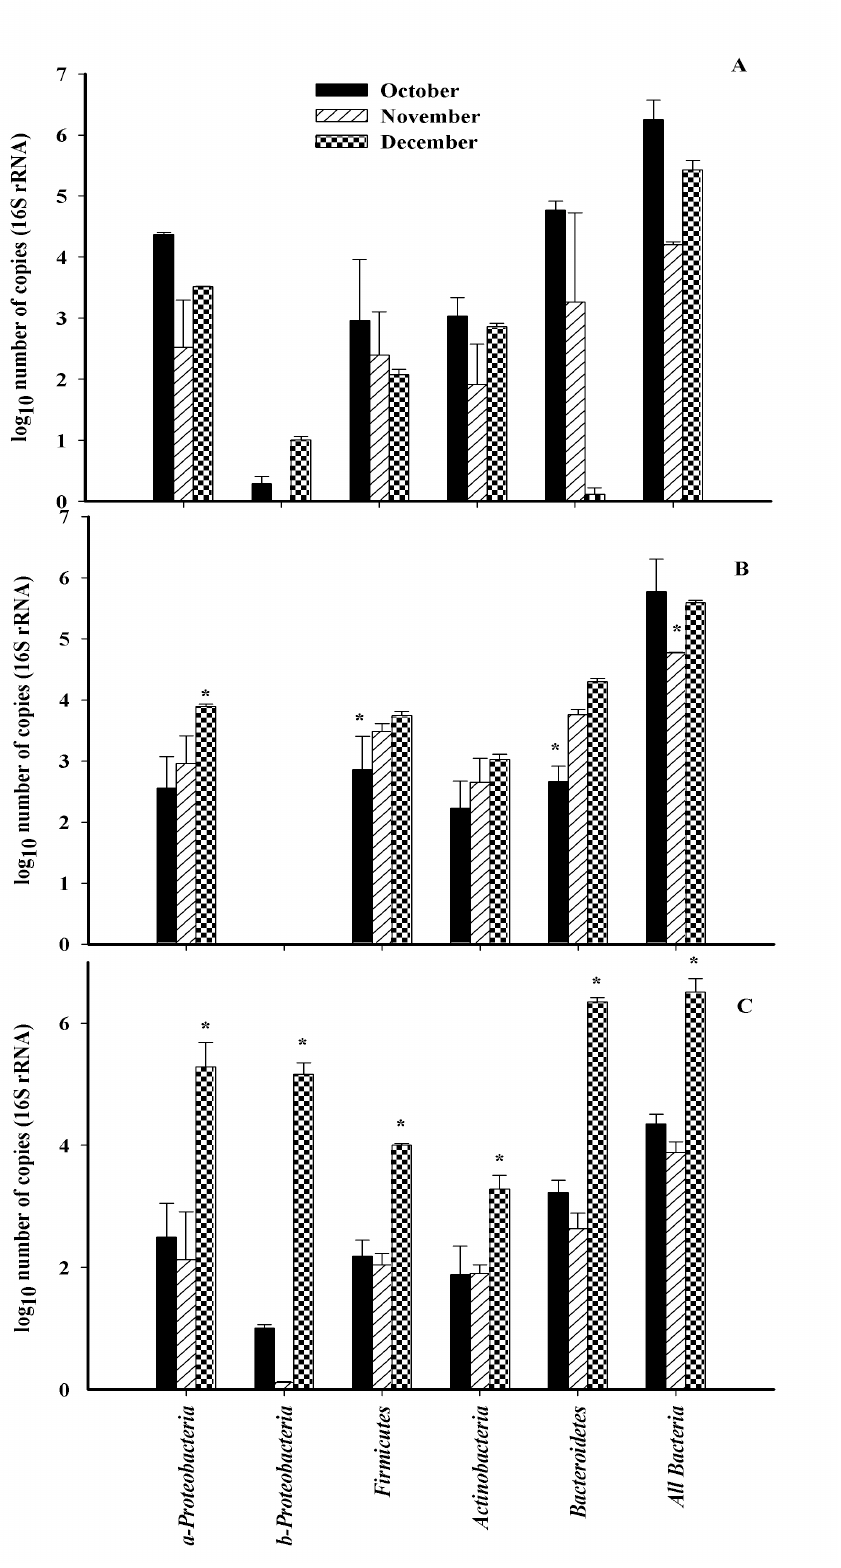
Figure 3. Abundance of members of five bacterial phyla in epiphytic communities isolated from “spinach cultivars (A) “Menorca, (B) “Monza, (C) Unipack, at three different harvest periods, determined by qPCR (n = 3). Error bars represent standard deviations of the mean. *Tukey comparison. P <